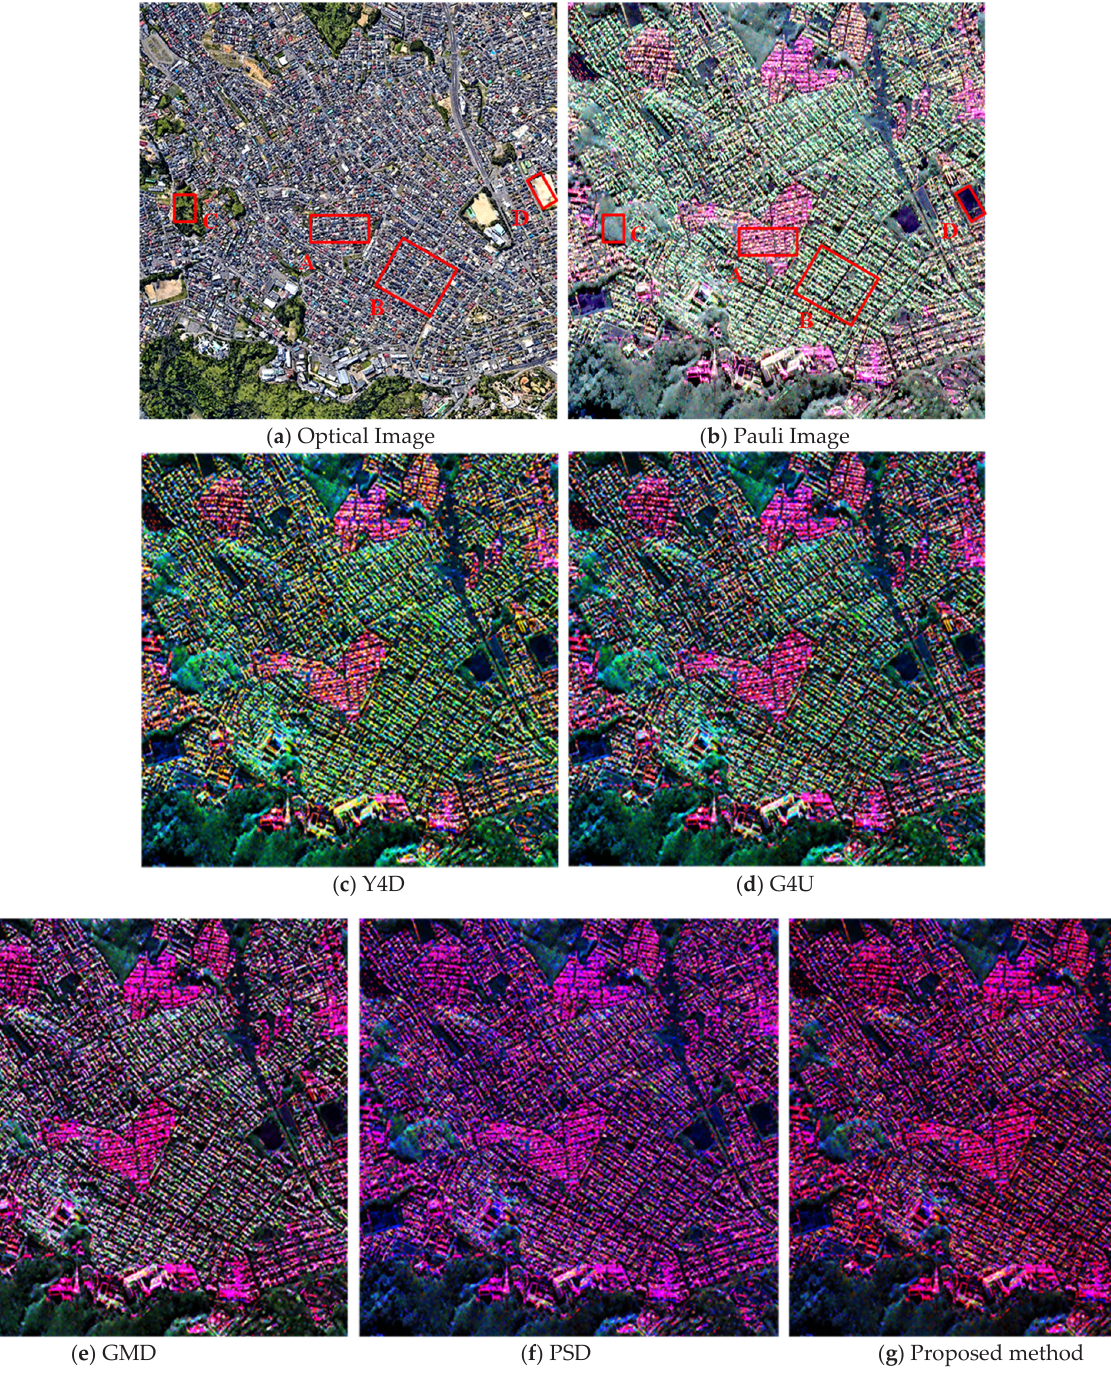
Figure 4. Decomposition results of PiSAR data. ( a , b ) are the optical image and Pauli image of the whole scene. The size is 1400 × 1400 pixels. ( c – g ) are the results of Y4D, G4U, GMD, PSD, and the proposed method. The images are colored by Pd (red), Pv (green), and Ps (blue).